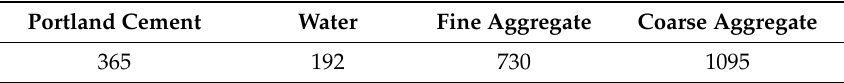
Table 1. Mix proportion of concrete specimen (kg/m 3